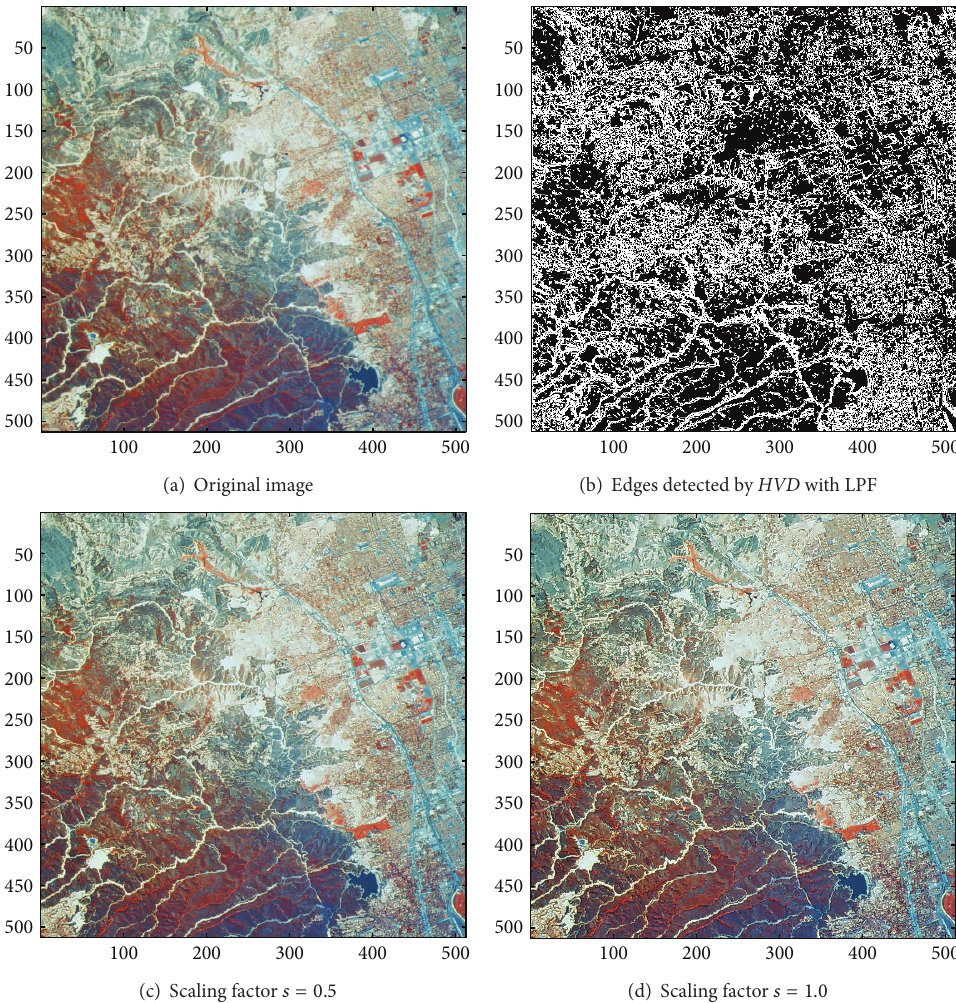
= 15 for HVD . (a) The image “Woodland Hills, CA” (512 × 512 color image). (b) Edges detected by HVD with LPF. (c and d) Figure 8: 𝜃 eth Sharpened results by HVD with scaling factors 0.5 and 1.0 ,